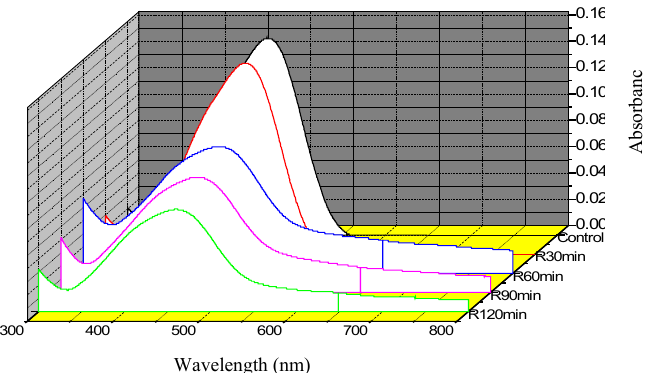
Fig. 8: % Degradation of Methyl orange dye using GS-SAgNPs and RAgNPs